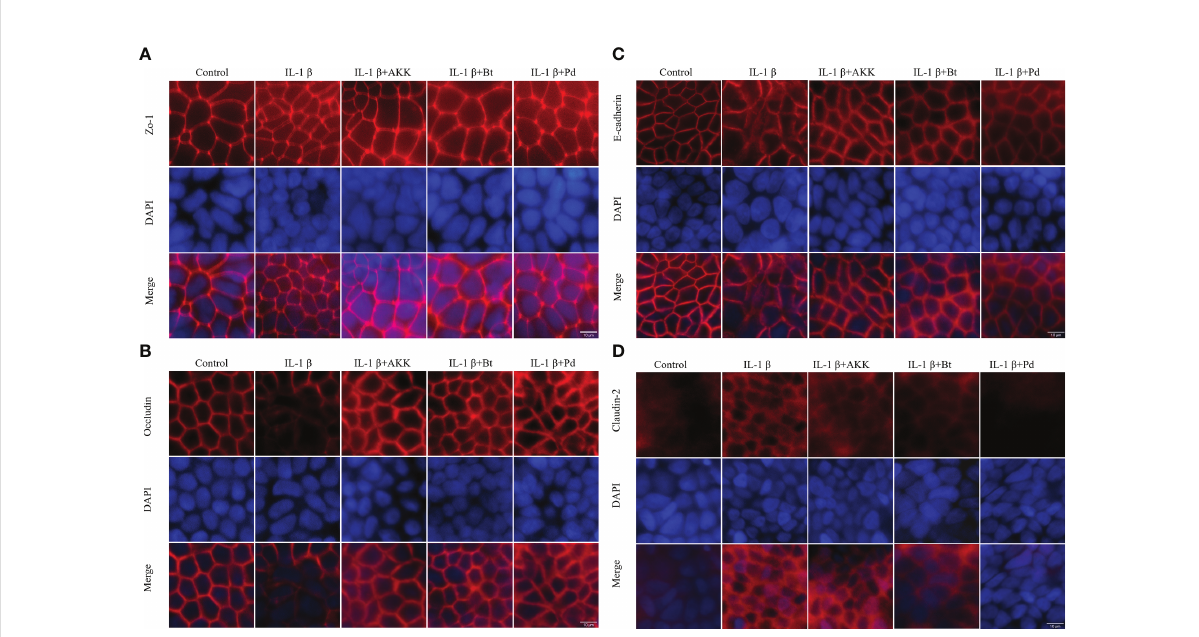
FIGURE 8 Protective effect of P. distasonis (Pd) , A . muciniphila (AKK) and B. thetaiotaomicron (Bt) on the immuno fl uorescence localization of TJ proteins in Caco-2 cell monolayers challenged by IL-1 b . Caco-2 cell monolayers were treated with IL-1 b and co-incubated with gut commensals for 24 h. TJ protein Zo-1 (A) , Occludin (B) , E-cadherin (C) , and Claudin-2 (D) were stained with the respective antibodies (red), and nuclei were DAPI stained (blue) and imaged by confocal microscopy. Images are of 100 × magni fi cation. Scale Bar = 10 m